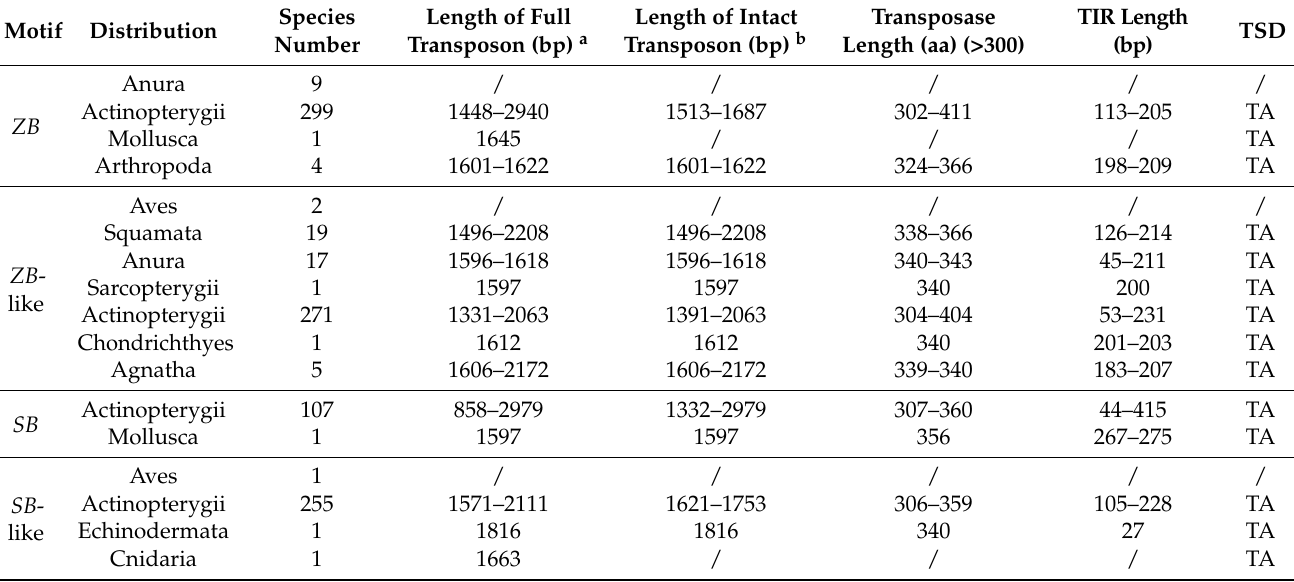
Table 1. Structural organization of ZB and SB